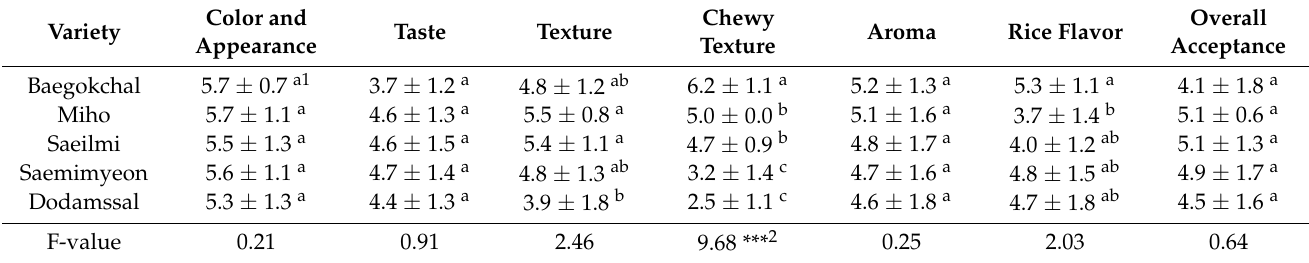
Table 3. Sensory scores on a 7-point numeric scale for ice cream made with processed